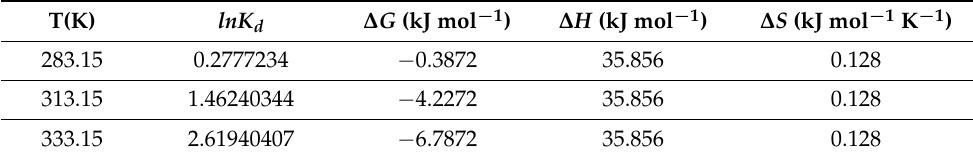
Table 7. Thermodynamic parameters of As adsorption in the D-Cr gel.